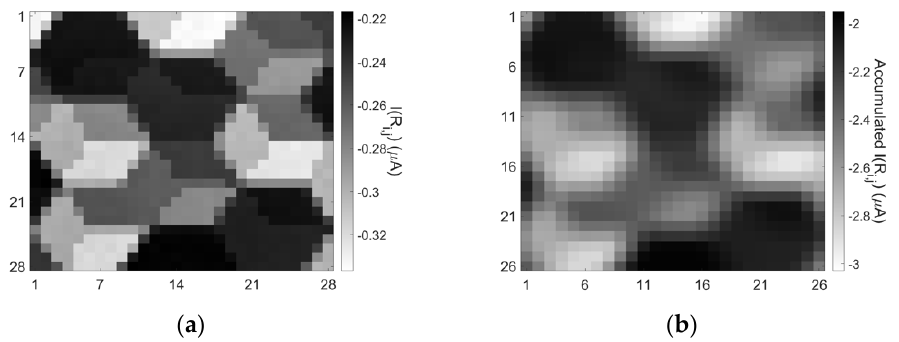
Figure 10. 28 × 28 1D1M vision sensor’s in-memory-computing SPICE simulation results for ( a ) an original image as was captured by the sensor and read row-by-row after 30 discrete light pulses on PDs. ( b ) A READ operation simultaneously with mean filtering. Table 2. In-sensor computing concepts based on RRAM devices.